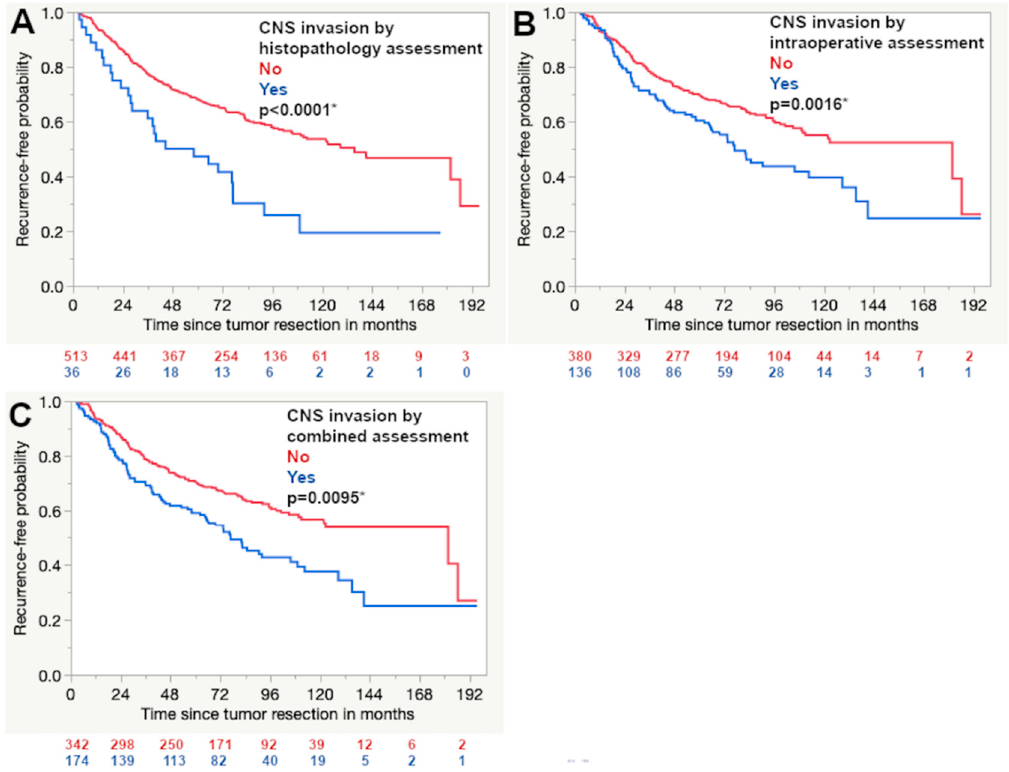
Figure 3. Kaplan–Meier curves demonstrate that the detection of CNS invasion by histopathology ( A ) and intraoperative assessment ( B ) were associated with a shorter progression-free survival. The combination of both detection methods was also a significant factor ( C ) (Log rank test, asterisk (*): statistically significant result).